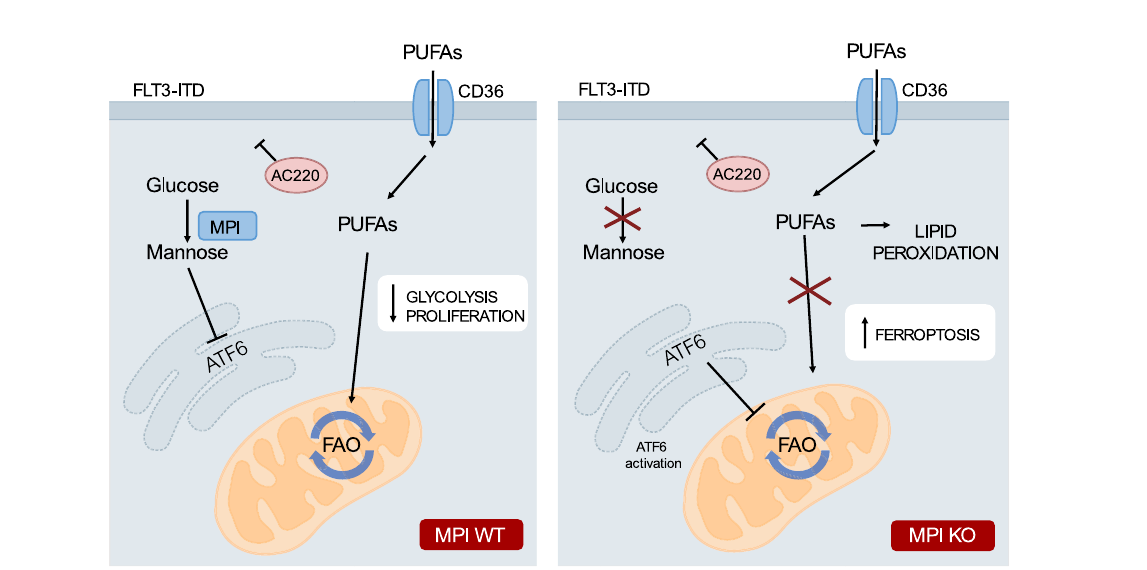
Fig. 8 | Model:lossofMPI leadsto celldeathinAMLthrough inhibitionofFAO leading to PUFA accumulation and ferroptosis. A model of the proposed mechanism. WT AMLcellstreated with both standardand FLT3inhibitor therapies areabletoescapecelldeathbyadaptingtheirmetabolism,inthiscasebyswitching from glycolysisto fatty acid oxidation.ConverselytreatedAMLcellswith depleted MPIhavepreferentialactivationoftheATF6armoftheunfoldedproteinsresponse